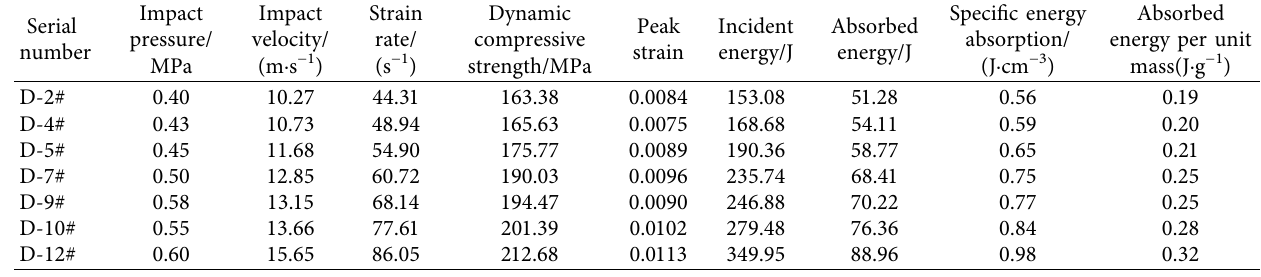
Table 2: Rock fragmentation characteristic parameters under different strain rates.